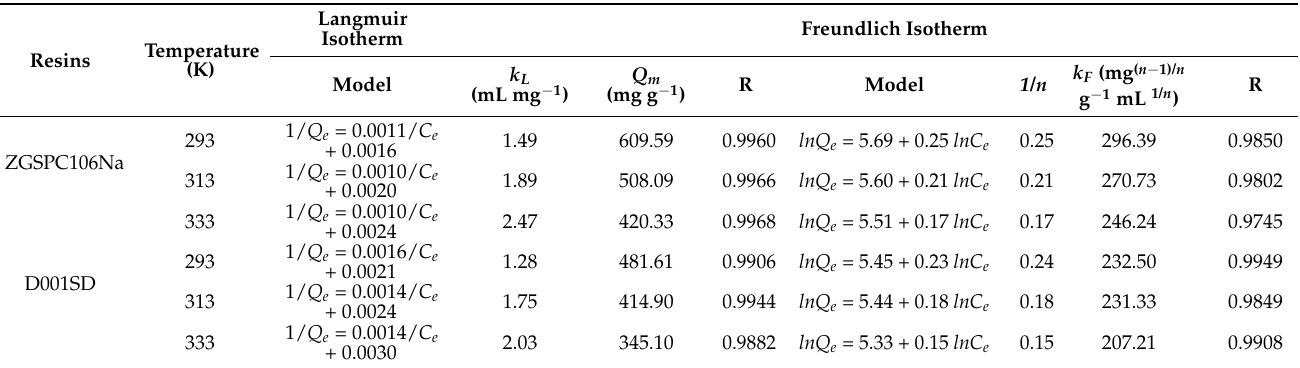
Table 4. Isothermal adsorption parameters of the L-theanine by the ZGSPC106Na and D001SD, according to Langmuir and Freundlich models.